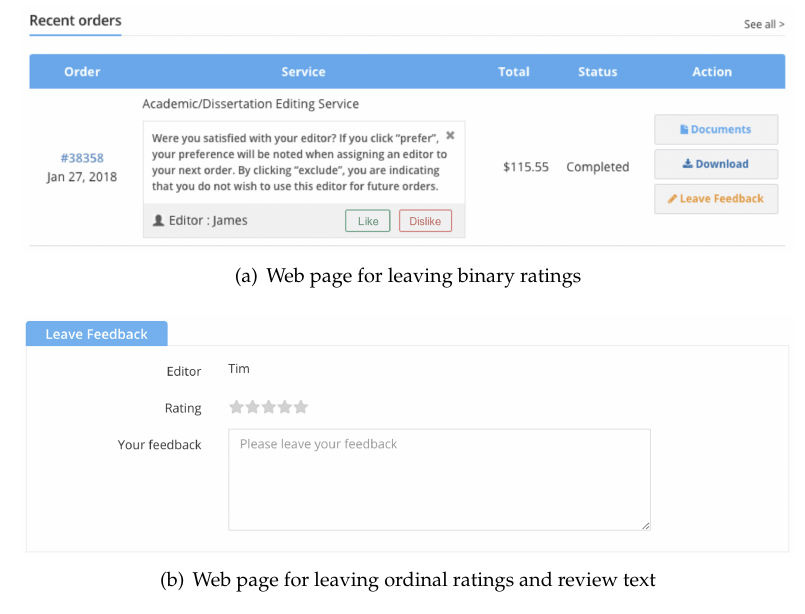
Figure 2. Screenshots of two web pages, where users leave their feedback, ( a ) binary ratings, ( b ) ordinal ratings and review texts, on the received editing